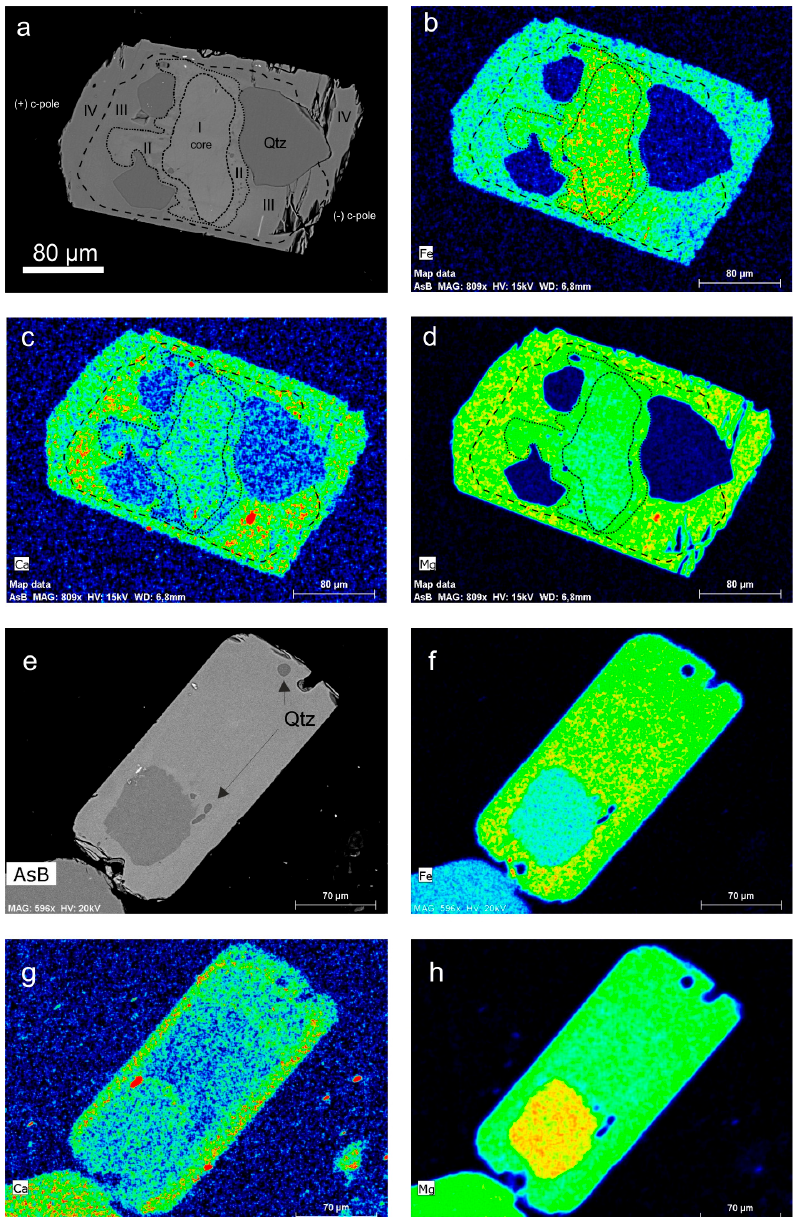
Figure 7. SEM-BSE images and elemental maps of zoned tourmaline grains from the Miechów Synclinorium showing their multi-stage growth. ( a – d ) detrital tourmaline grain from Glanów–Stroniczki: ( a ) SEM-BSE image, distinct chemical zonation (I–IV) is underlined with dotted lines; ( b – d ) distribution maps of Fe ( b ), Ca ( c ) and Mg ( d ). ( e – h ) detrital tourmaline from Lelów : ( e ) SEM-BSE image of tourmaline grain with clearly visible growth zones. The core of the grain is strongly enriched in Mg, ( f – h ) distribution maps of Fe ( f ), Ca ( g ) and Mg ( h ). All Elemental maps with false colour scale; dark blue—lowest concentrations, red—highest concentrations of analysed element; Qtz—quartz. Table 2. Mineral chemistry of distinguished zones (I–IV) in multistage tourmaline grain from Glanów–Stroniczki.